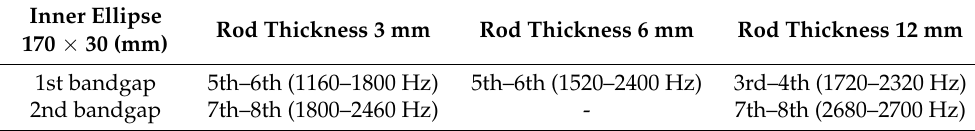
Figure 15. Response for inner ellipse 170 × 90, rod 12 mm. ( a ) microstructure, ( b ) responce for first eigenfrequenciew. One band gap is shown, between 3rd and 4th eigenfrequency (950–1530 Hz). Table 3. Parametric investigation. Inner ellipse 170 × 30.